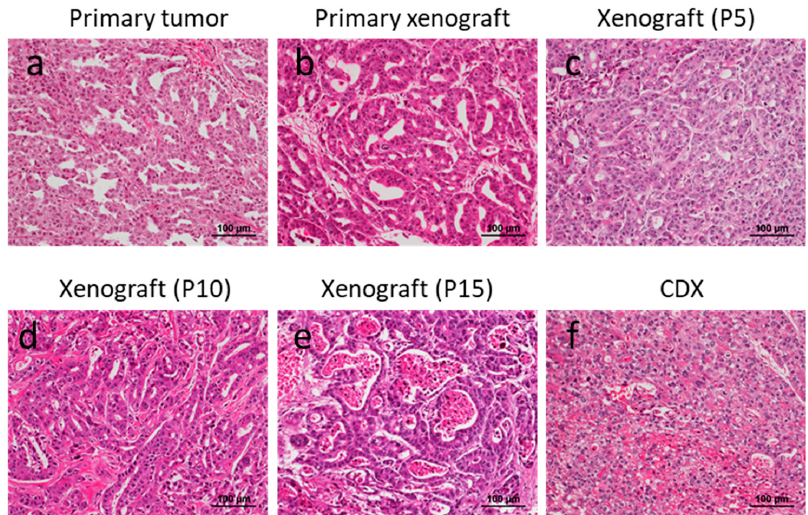
Figure 5. Comparison of histology after sequential re-engraftment into SCID mice. A primary xenograft tumor ( b ) as well as sequentially engrafted xenograft tumors ( c – f ) morphologically resemble the primary tumor ( a ).